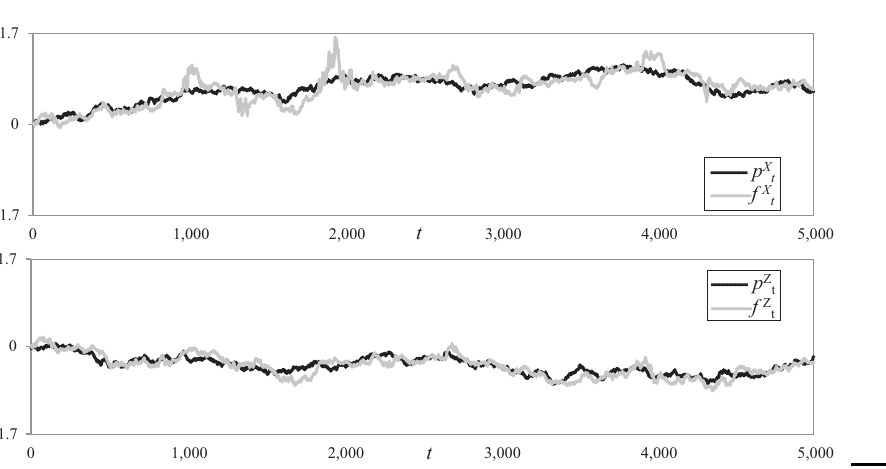
Figure 1. Evolution of log- prices for the two markets